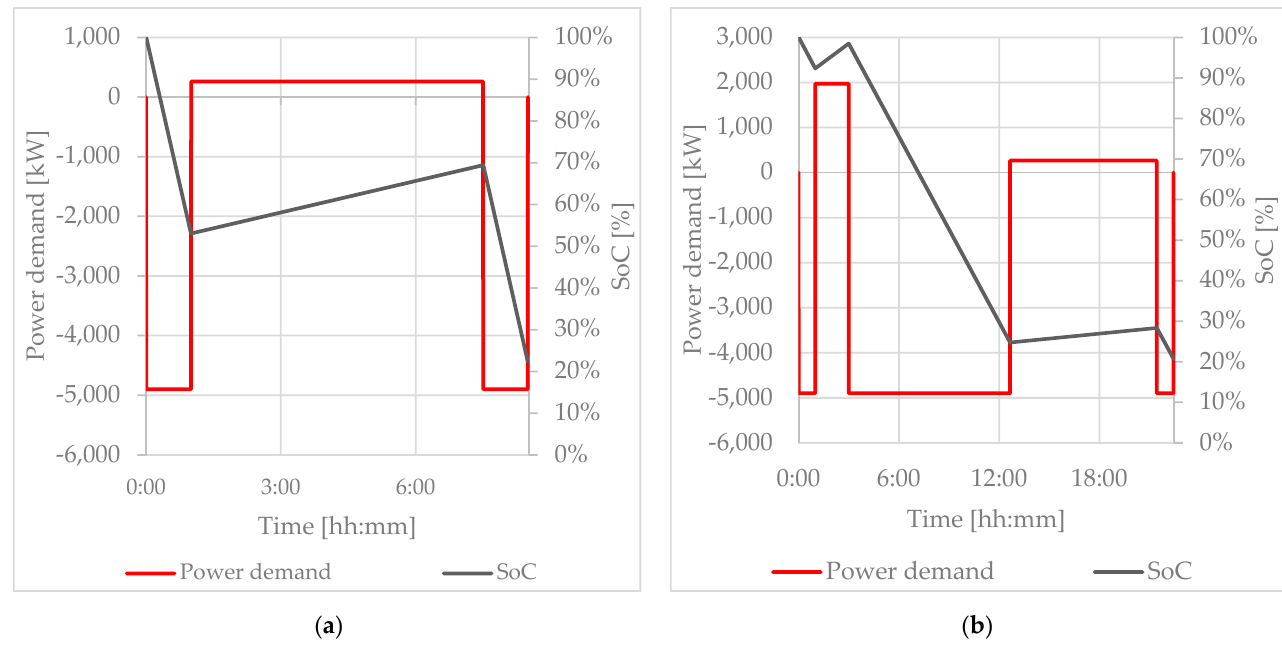
Figure 13. Power demand and state of charge (SoC) of onboard batteries changes during the cursing ( a ) for variant 1 ( b ) for variant 2.